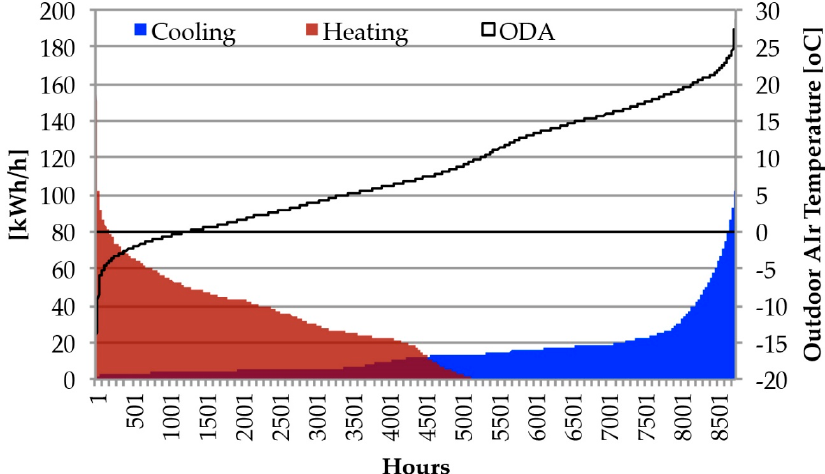
Figure 5. Duration curve for heating, cooling, and outdoor temperature (ODA). 1 April 2016 ‒ 31 March 2017.